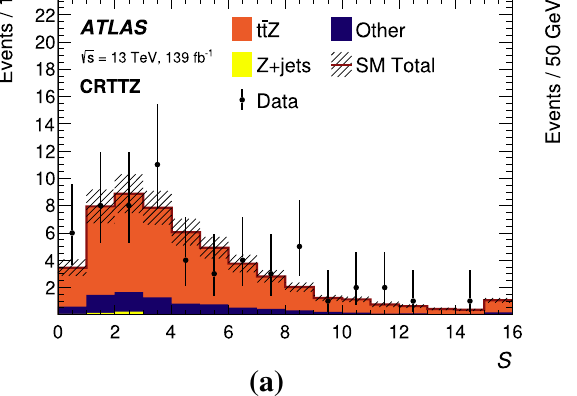
expectation includes the combination of MC statistical, theory-related and detector-related systematic uncertainties. The rightmost bin in each plot includes all